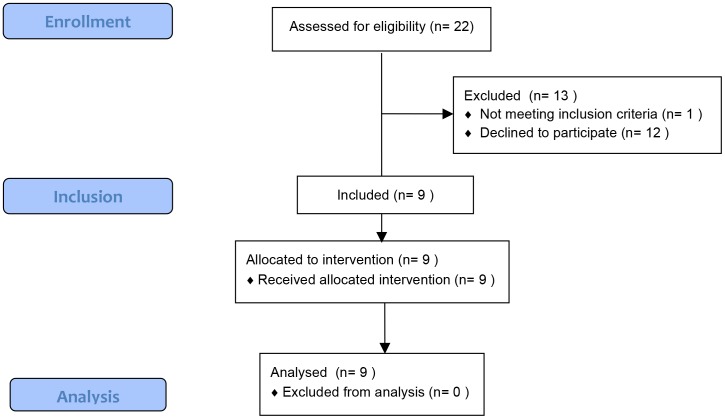
CONSORT flow chart.